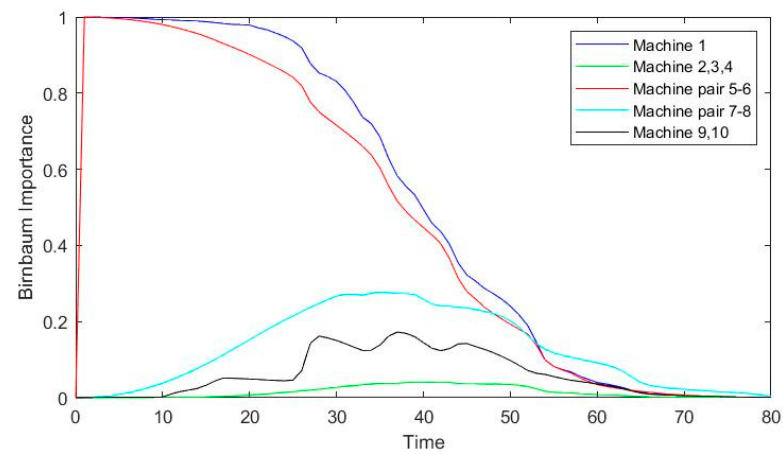
Figure 12. Machine Birnbaum importance (Case 1).